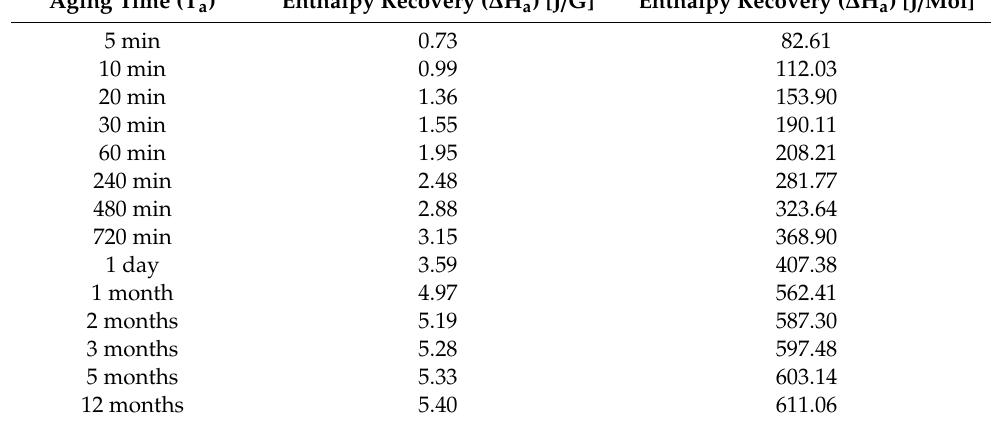
Figure 7. Enthalpy recovery vs. aging time at T a = 400.15 K for the amorphous PNIPA. The solid line is the result of fit the experimental data to Kohlrausch – Williams – Watts (KWW) function (R 2 = Table 1. The change of enthalpy recovery ( ∆ H a ) of PNIPA versus the di ff erent aging time (t a ). 0.9894).